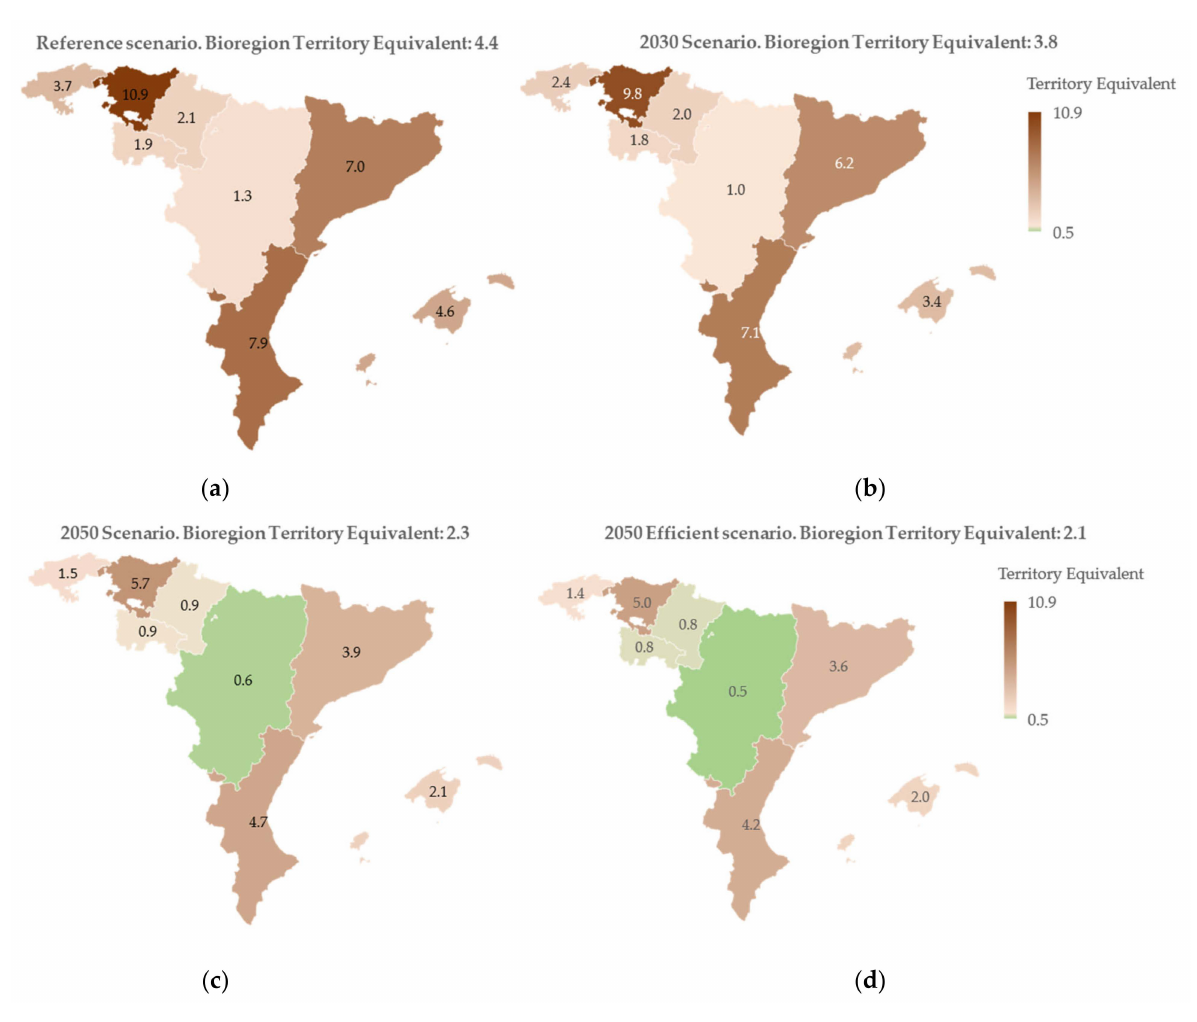
Figure 10. Bioregion Territory Equivalent. ( a ) Reference scenario. Data obtained from [92]; ( b ) 2030 Scenario; ( c ) 2050 Scenario; ( d ) 2050 Efficient